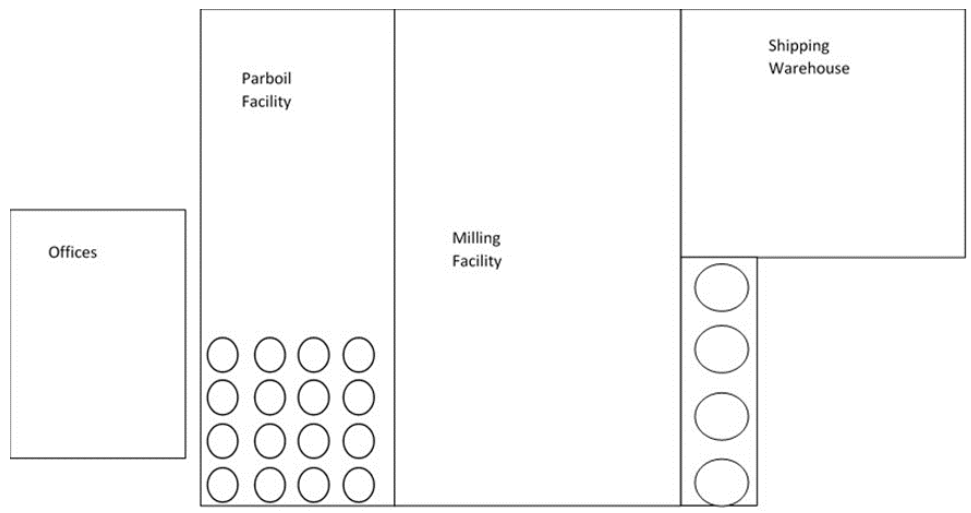
Figure 1. General layout of milling complex tested.